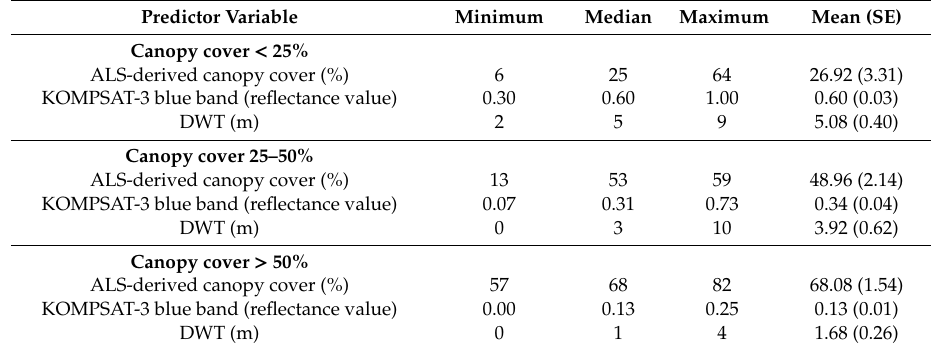
Table 1. Predictor variable values for low, moderate, and high canopy plots. Minimum, median, maximum, and mean values (including standard error (SE)) are provided for airborne laser scanning (ALS)-derived canopy cover, KOMPSAT-3 blue band, and depth to water table